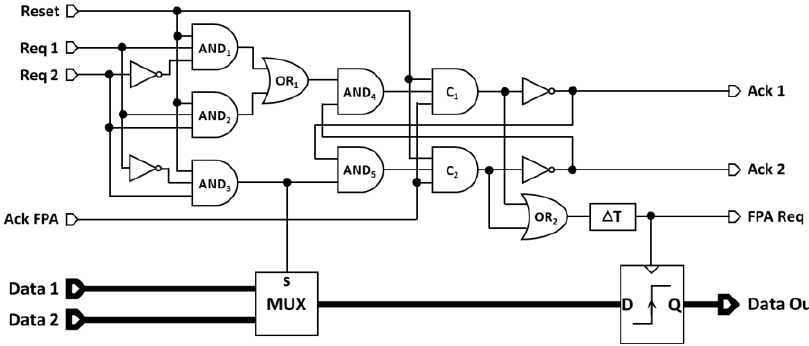
Figure 7. The proposed two-to-one FPA schematic. The upper part is the control unit that manages the priority and the Request/Acknowledge protocol. The lower part is the process unit that selects the good data to be stored in the flip-flop register according to the requested input Req1 or Req2.